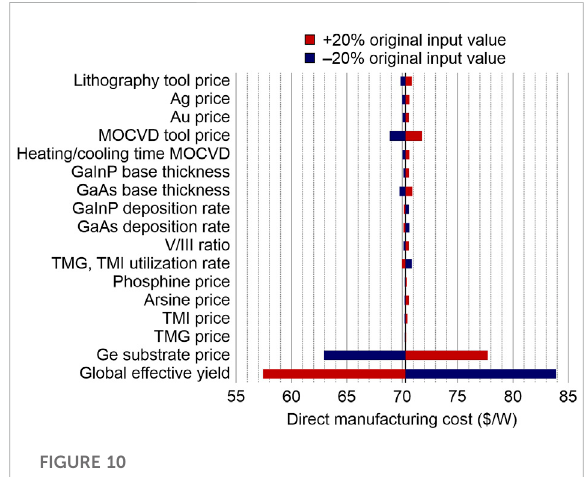
FIGURE 10 Sensitivity of III-V//Ge 3-J solar cells manufacturing costs. Image adapted from (Horowitz et al.,